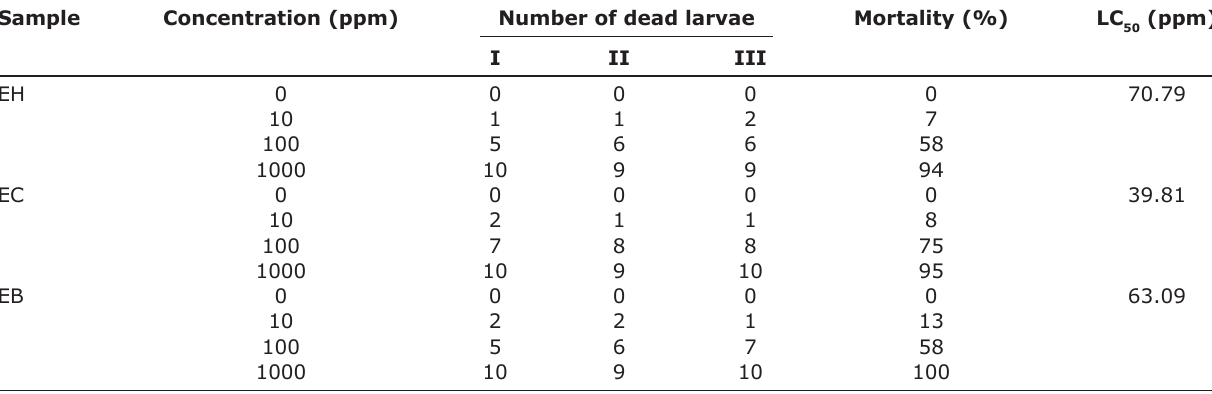
Table-1: Toxicity of n-hexane, chloroform, and n-butanol extracts. Sample Concentration (ppm)